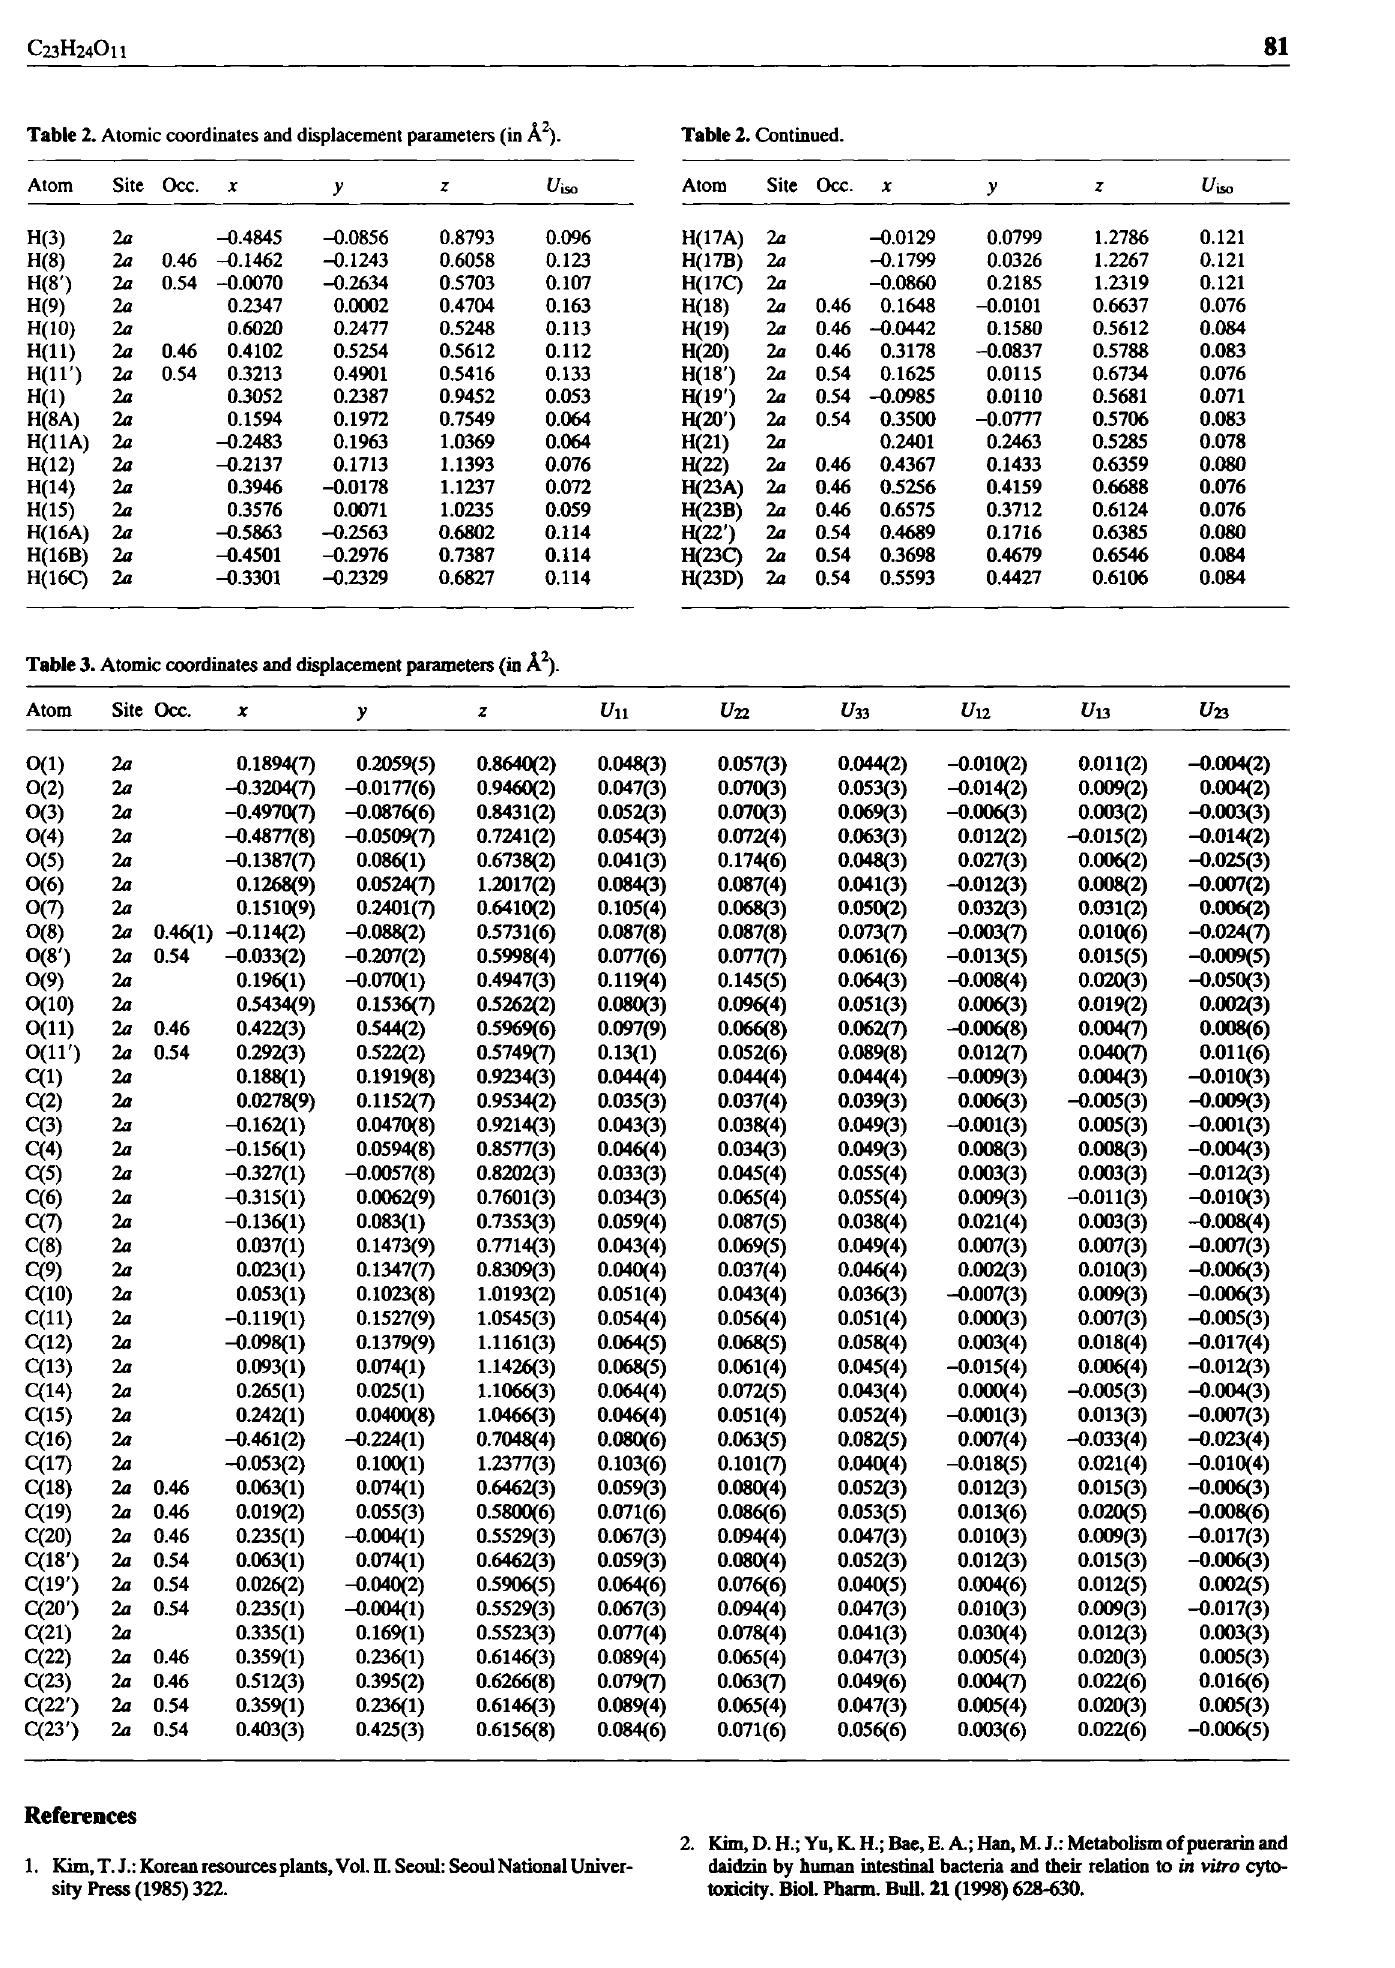
Table 3. Atomic coordinates and displacement parameters (in A 2